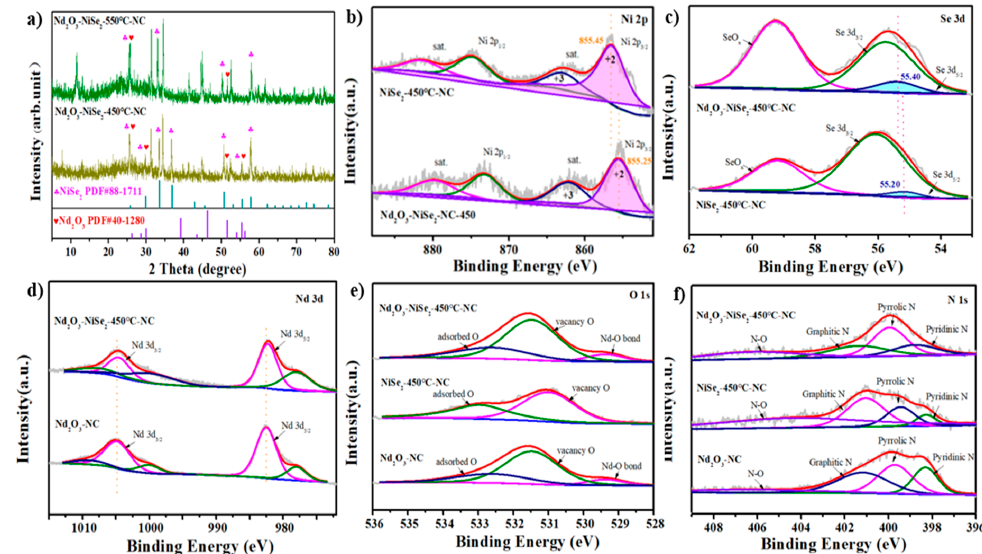
Figure 3. ( a ) XRD patterns of Nd 2 O 3 -NiSe 2 -450 ◦ C-NC and Nd 2 O 3 -NiSe 2 -550 ◦ C-NC; XPS spectrum tests of ( b ) Ni 2p, ( c ) Se 3d, ( d ) Nd 3d, ( e ) O 1s, and ( f ) N 1s of Nd 2 O 3 -NiSe 2 -450 ◦ C-NC, NiSe 2 -450 ◦